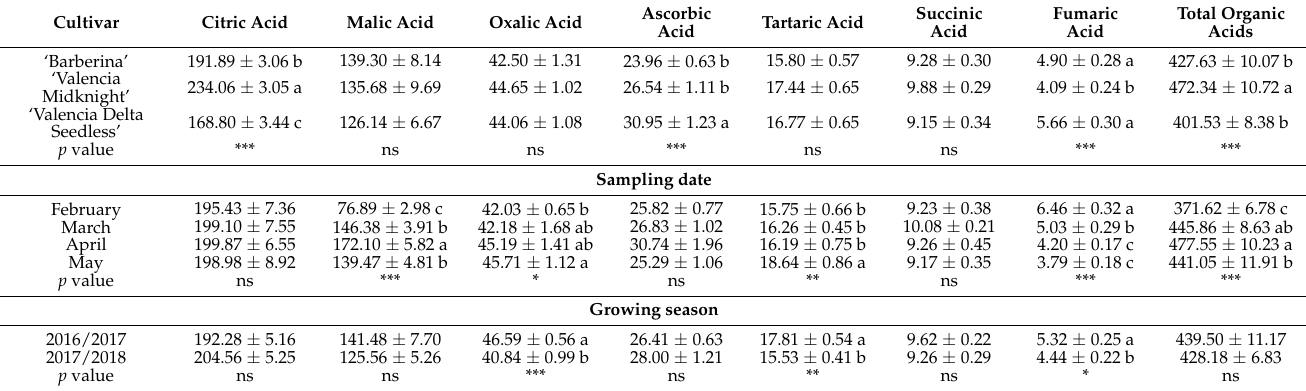
Values with different letters are significantly different among cultivars, sampling date (month) or growing season, by LSD-Fisher test ( p < 0.05). Significant level: ns = not significant; * = p < 0.05; ** = p < 0.001; *** = p <